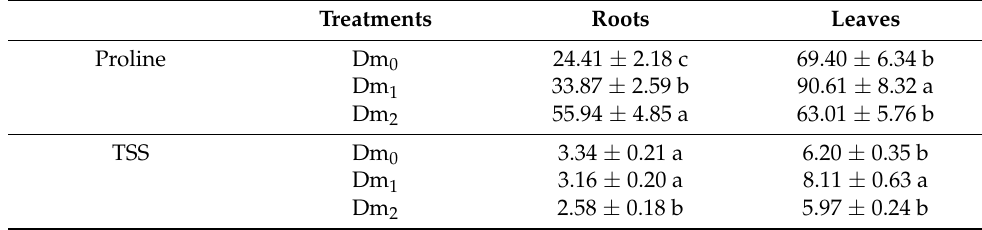
Table 5. The effects of different fertigation treatments (Dm 0 —standard nutrient solution, Dm 1 —raw leachate treatment, and Dm 2 —raw leachate blended with H 2 O 2 treatment) on root and leaf proline and total soluble sugars (TSS) concentrations in D. marginata plants at the end of the experiment. The results are expressed as means ± standard deviation ( n = 4). In each column, the same letters indicate non-significant differences ( p <